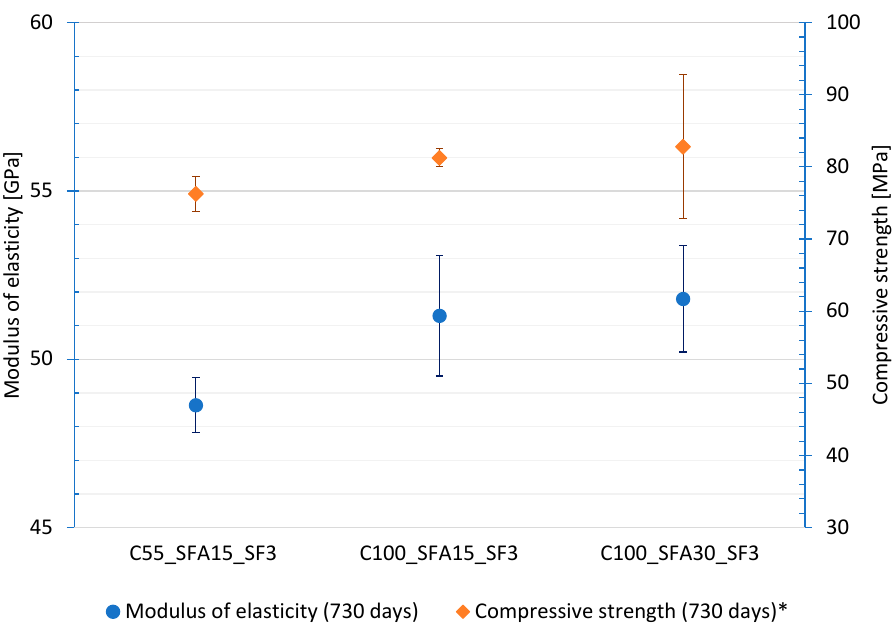
Figure 6. Average modulus of elasticity and compressive strength values for HPC (730 daysafter specimen preparation); *—compressive strength values obtained on cylindrical specimens. Table 7. Comparison between modulus of elasticity values obtained from tests (according to EN 12390-13) and those estimated by three different models: ACI 363 [30], EN 1992-1-1 [26] and NS 3473 [31].